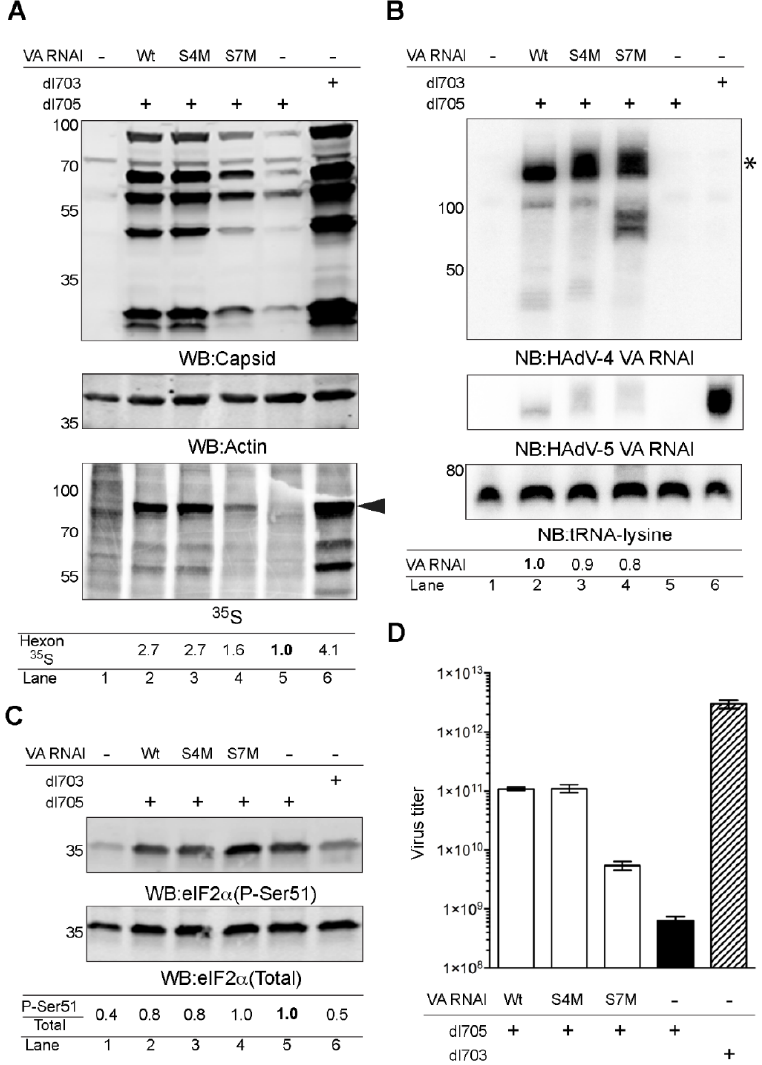
Figure 3. HAdV-4 VA RNAI (S7M) is partially deficient in complementing VA RNAI-lacking virus (dl705) growth. ( A ) Virus capsid protein production in dl705 virus-infected and transient HAdV-4 VA RNAI expressing HEK293 cells. Whole-cell lysates were analyzed by western blotting (WB) and autoradiography ( 35 S). The hyphen (-) indicates a sample transfected with a control plasmid, pUC19. The plus (+) indicates a virus-infected sample. The black arrowhead indicates the migration of the virus capsid protein, hexon. Relative synthesis of the 35 S-labelled hexon protein is shown below the image. ( B ) Ectopic expression of HAdV-4 VA RNAI mutants in HEK293 cells. Total RNA was analyzed by northern blotting (NB) with probes against VA RNAI and tRNA-lysine. Relative HAdV-4 VA RNAI expression from two independent experiments is shown below the image. The asterisk (*) marks the full-length HAdV-4 VA RNAI. ( C ) The same protein lysates as shown in ( A ) were re-analyzed using the anti-eIF2 α (Total) and anti-eIF2 α (P-Ser51) antibodies. Relative accumulation of the P-Ser51 signal in the total eIF2 α protein pool (P-Ser51/Total) from two independent experiments is shown. ( D ) Formation of infectious virus particles in HAdV-4 VA RNAI expressing HEK293 cells. Virus titers were determined in 911 cells after re-infection with HEK293 cell lysates transfected with the indicated plasmids and infected with VA RNAI-deficient dl705 virus. The bars denote the mean virus titer (log10) ± standard deviation of the means. In all of the experiments, wild-type HAdV-5 virus (dl703), expressing both VA RNAI and VA RNAII, was used as the